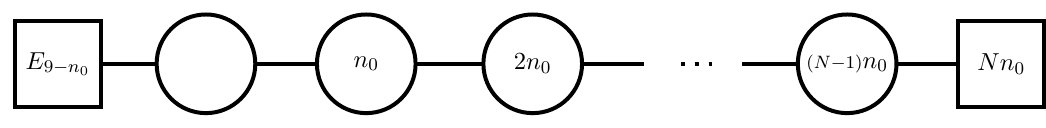
Figure 6 . The quiver diagram of our six-dimensional theory in the general